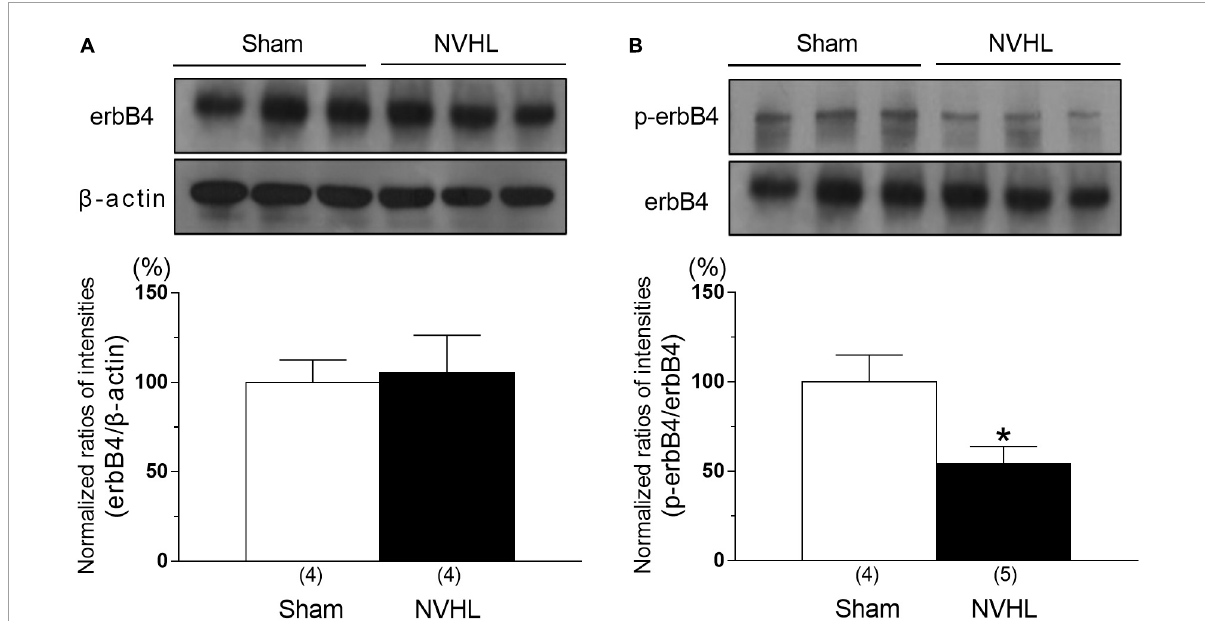
FIGURE3 Alternation of erbB4 and p-erbB4 level in the PFC in the NVHL rats at post-pubertal period. Representative immunoblots probed with antibodies against β -actin, erbB4 (A) , and p-erbB4 (B) , as indicated. Quantification of the normalized values of erbB4 levels with β -actin (A) and p-erbB4 levels with erbB4 (B) , respectively. Numbers in square brackets indicate the number of animals in each group. Bars represent means ± SEM. * p < 0.05 vs. sham group.